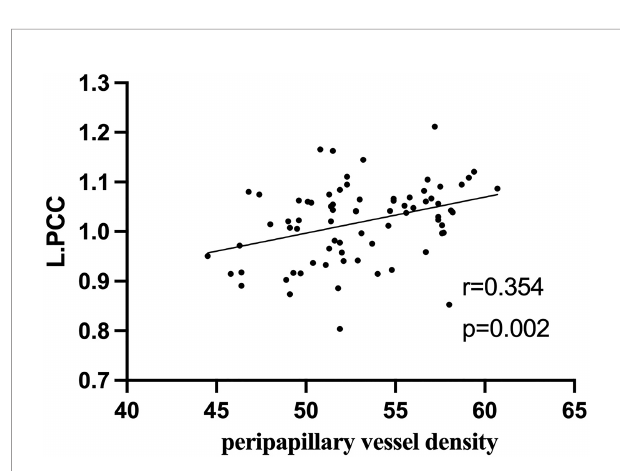
FIGURE 5 | In active TAO group, the fALFF values in L.PCC were positively correlated with peripapillary vessel density (r = 0.354, p = 0.002).